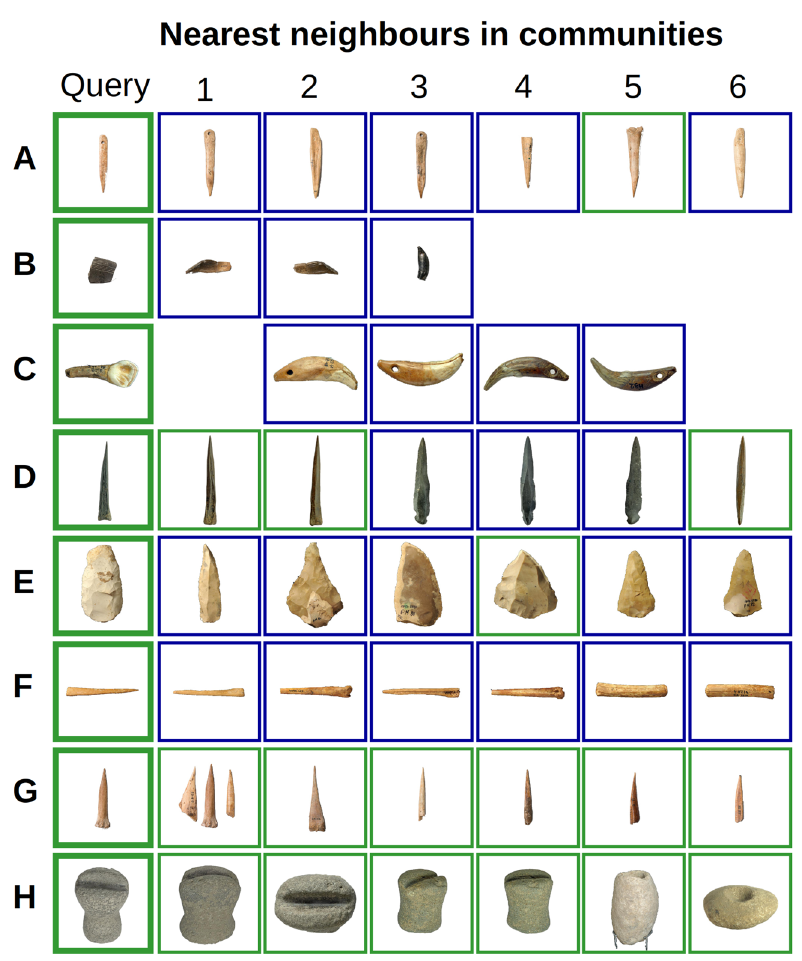
Fig. 4 Natu fi an artefact image confusion in community detection case-study. The query images are presented in the left column, while, to their right, the nearest training-set neighbours are presented in order. If the neighbour is of the same class as the query (i.e., of the same site and period), it is placed in a green frame. Otherwise, a blue frame is used. A blank space indicates that the neighbour image detected by the model was assigned to a different community. A more detailed description of this fi gure can be found in supplementary material (Additional information for Fig. section). A Community 1, archaeologically meaningful confusion. B Community 1, wrong confusion. C Community 2, archaeologically meaningful confusion. D Community 2, wrong confusion. E Community 3, archaeologically meaningful confusion. F Community 3, confusion. G Community 4, correct predictions. H Community 5, correct